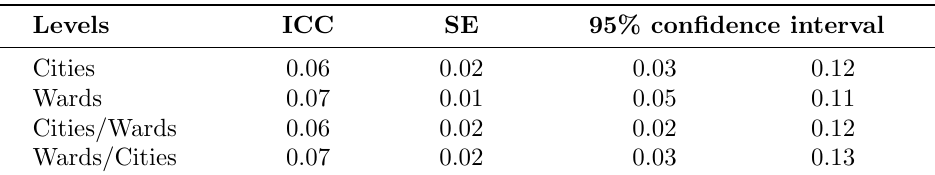
Table 2: Intra-class correlation coefficients: cities, wards, cities and wards. New Zealand 2008 Levels Cities